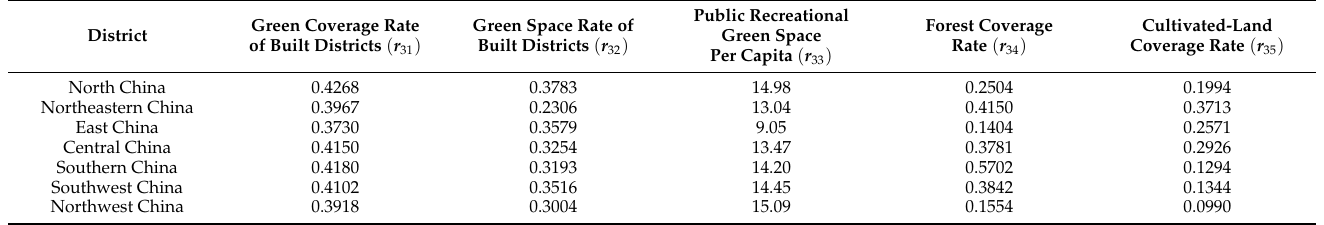
Table 5. Mean value of green infrastructure ecological function evaluation index in different regions. Green Space Rate of Built Districts ( r 32 ) 31 )